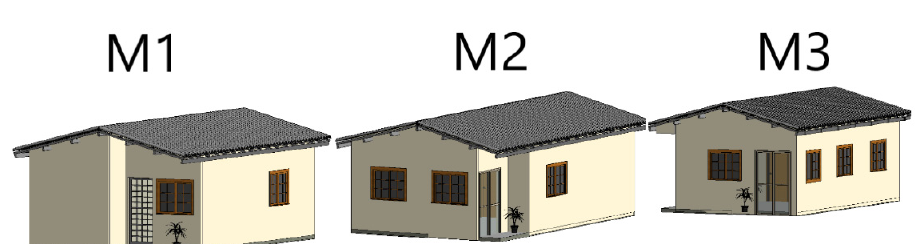
Figure 7. Floor plans.